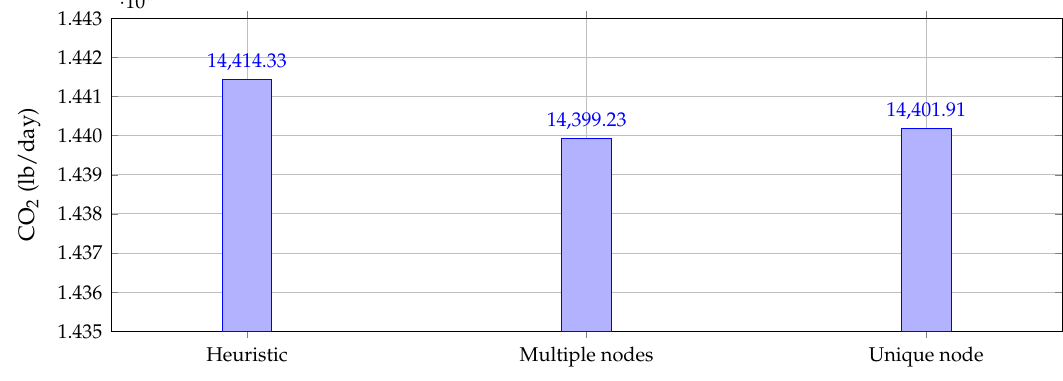
Figure 5. Emissions of CO 2 when the voltage in the slack node is left